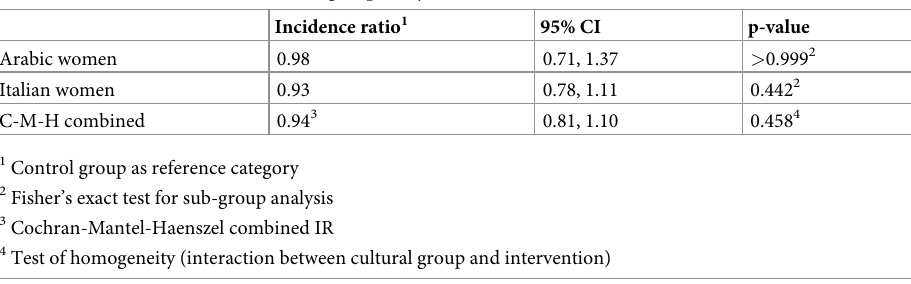
Table 3. Comparison of screening appointment booking rates according to cultural group in the letters trial: Cochran-Mantel-Haenszel test and sub-group